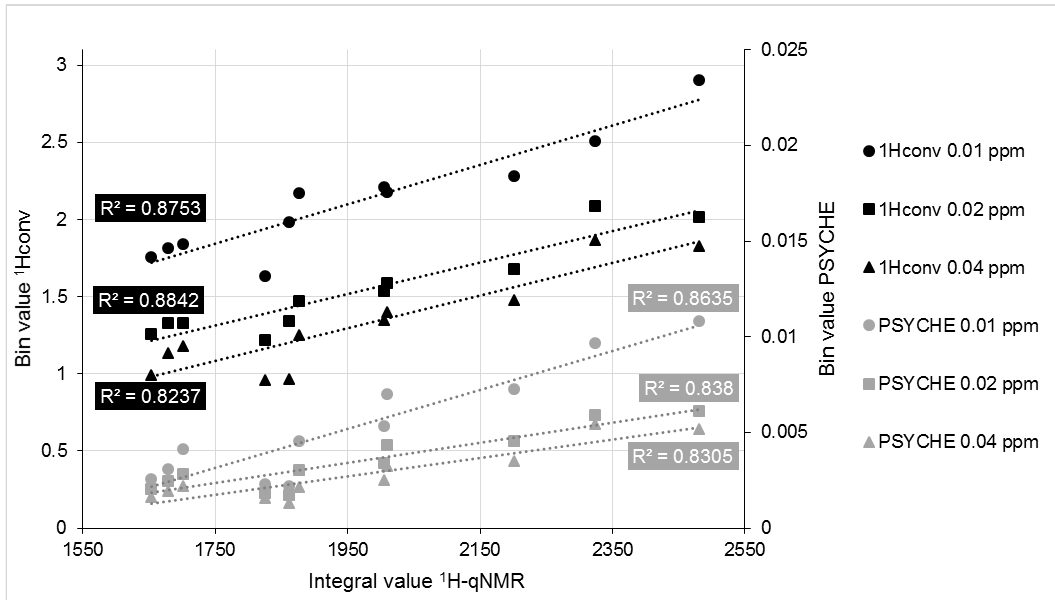
Table 1. Summary of the coefficient of determination (R 2 ) after linear regression between 1 H-qNMR integrals and bin values of different experiments with bin size 0.02 ppm (Supplement S.2). Numbering scheme of compounds is shown in Figure S.1. Figure 5. Linear regression between the integral of the signal at 1.08 ppm from the 1 H-qNMR measurement, and the corresponding bin value of the conventional 1 H-NMR (1Hconv, black) and the PSYCHE (grey) experiment with different bin sizes. The coefficient of determination, R 2 , was calculated for each graph.